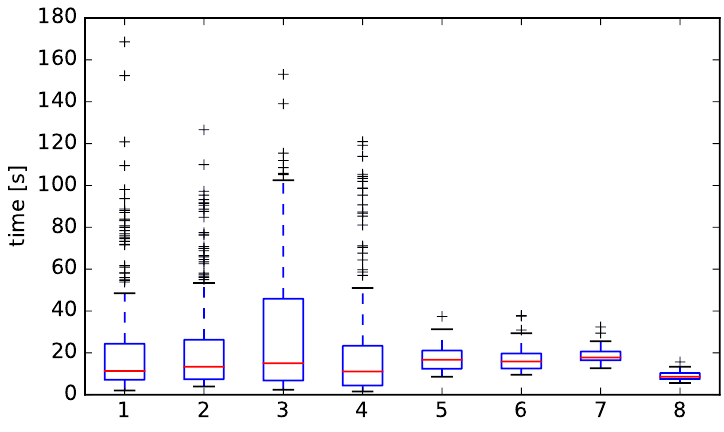
Figure 12. Computational time boxplots for each optimization alternative. Each datum corresponds to the optimization time for a given combination of control